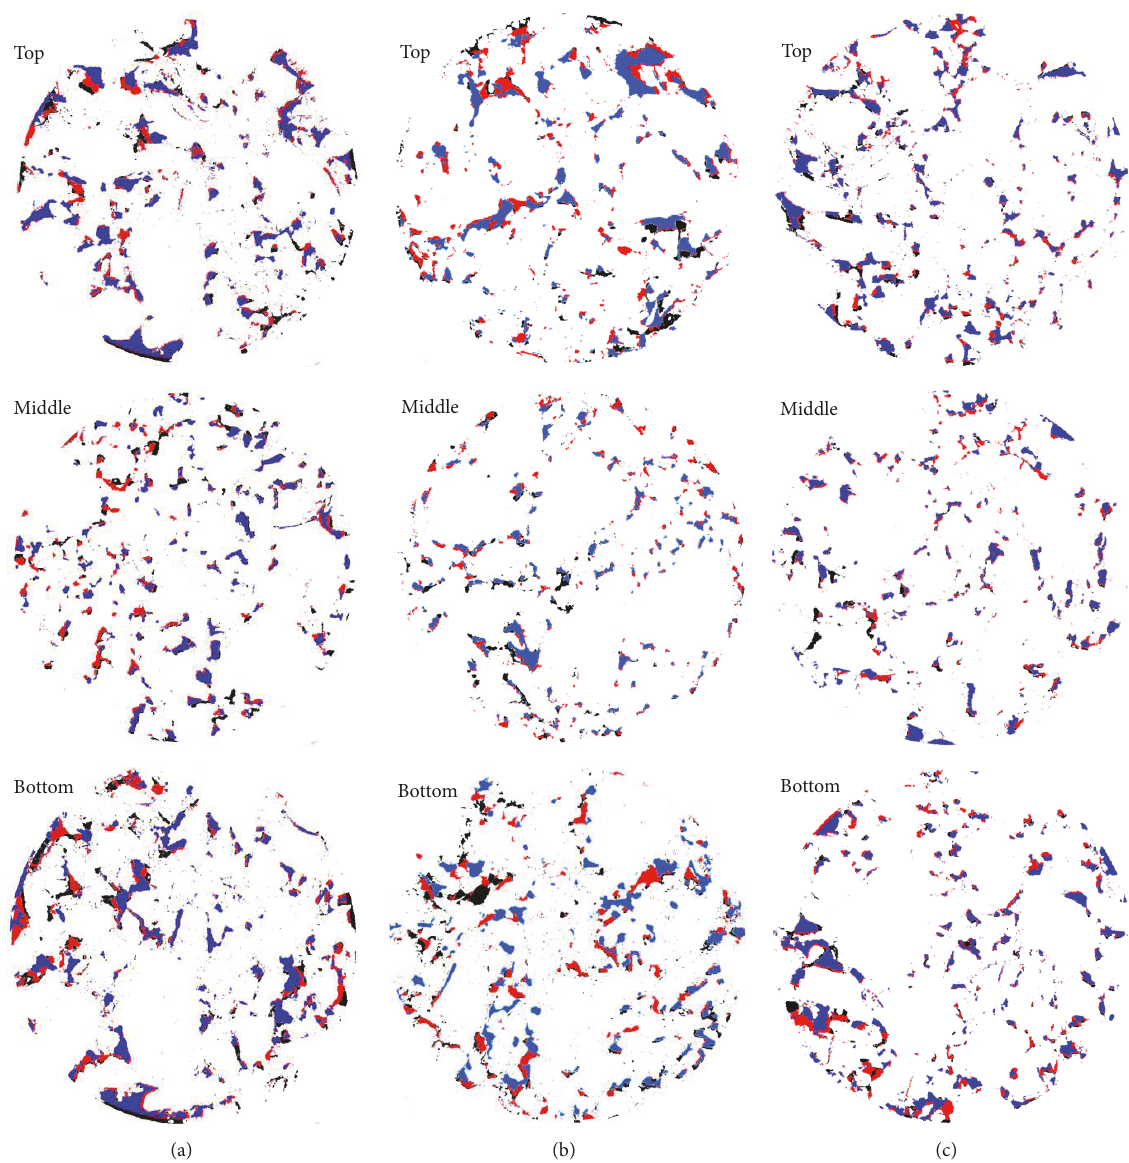
Figure 16: Change of the internal structures of the SRBM samples along the horizontal direction when the curing time was 90 d: (a) cement content = 4.0%; (b) cement content = 4.5%; (c) cement content =